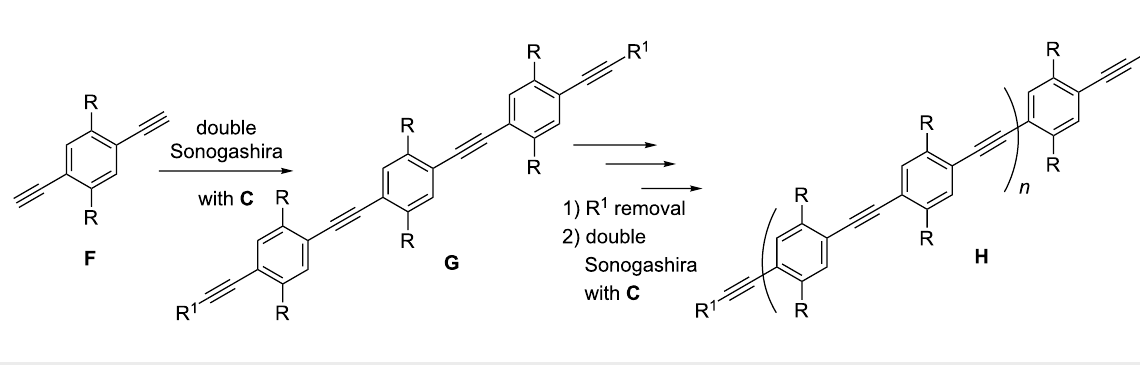
Figure 4: Synthetic strategy for rigid spacers with an odd number of units.